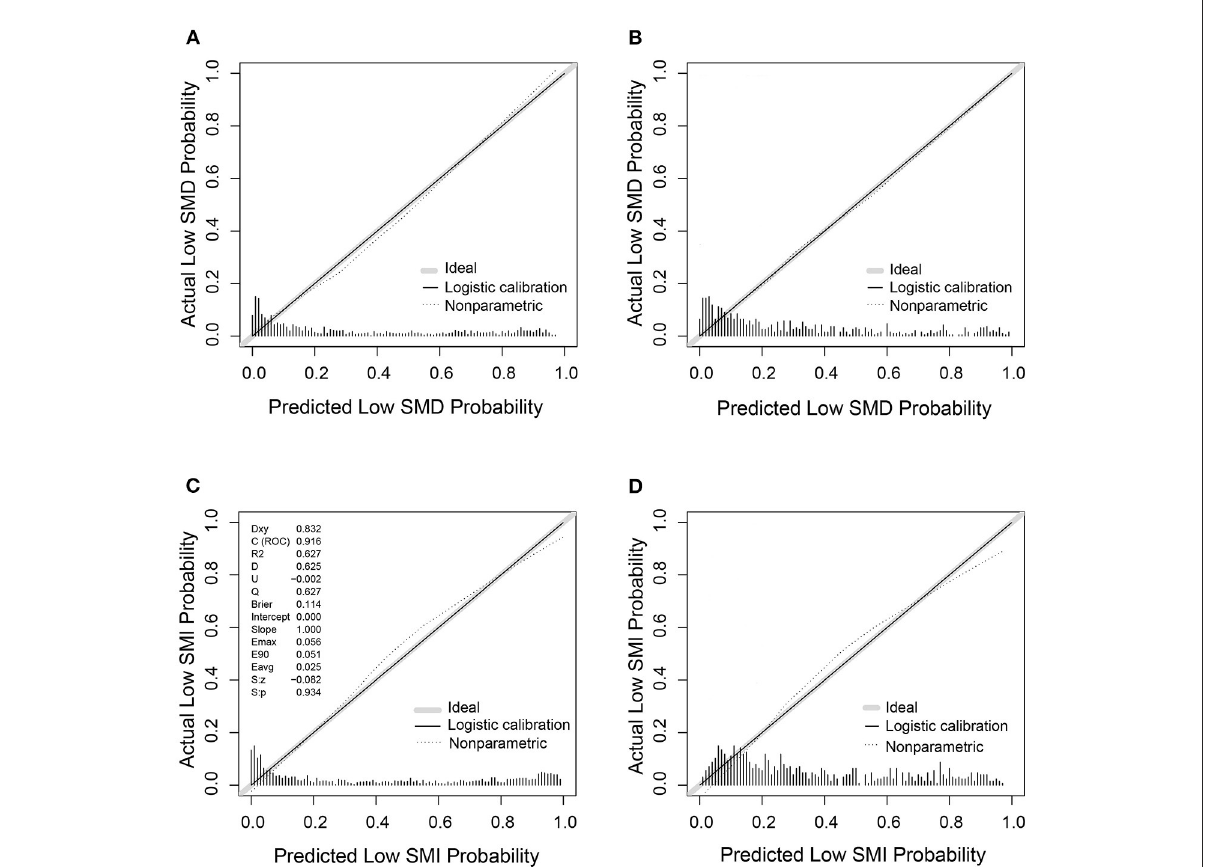
FIGURE4 The calibration curves of nomogram for predicting low SMD and low SMI based on the training ( n = 1,005) and validation ( n = 632) cohorts. (A) The calibration curve for low SMD predictions in the training cohort. (B) The calibration curve for low SMD predictions in the validation cohort. (C) The calibration curve for low SMI predictions in the training cohort. (D) The calibration curve for low SMI predictions in the validation cohort.